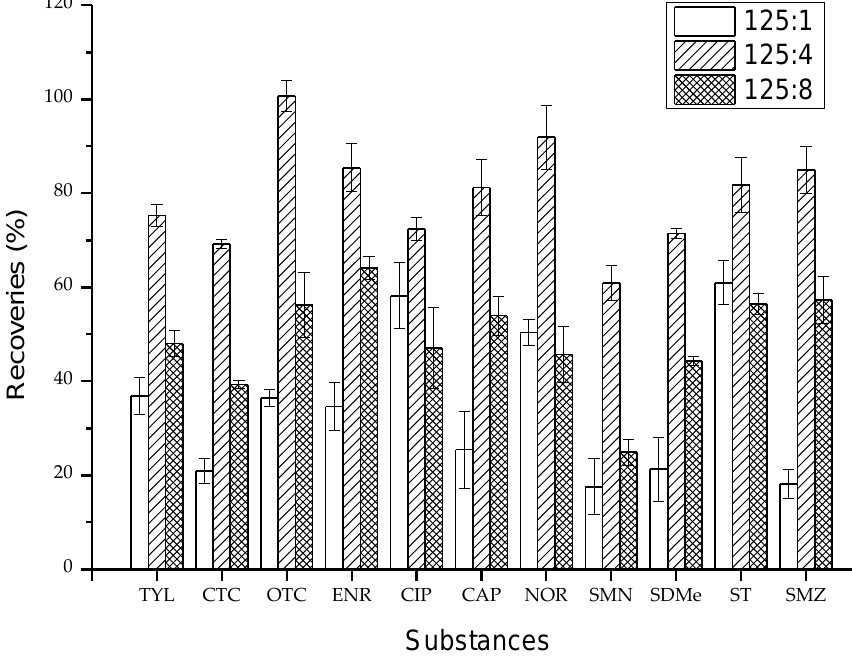
Figure 1. Comparison of 11 antibiotics recoveries from three different extraction methods for vegetables.